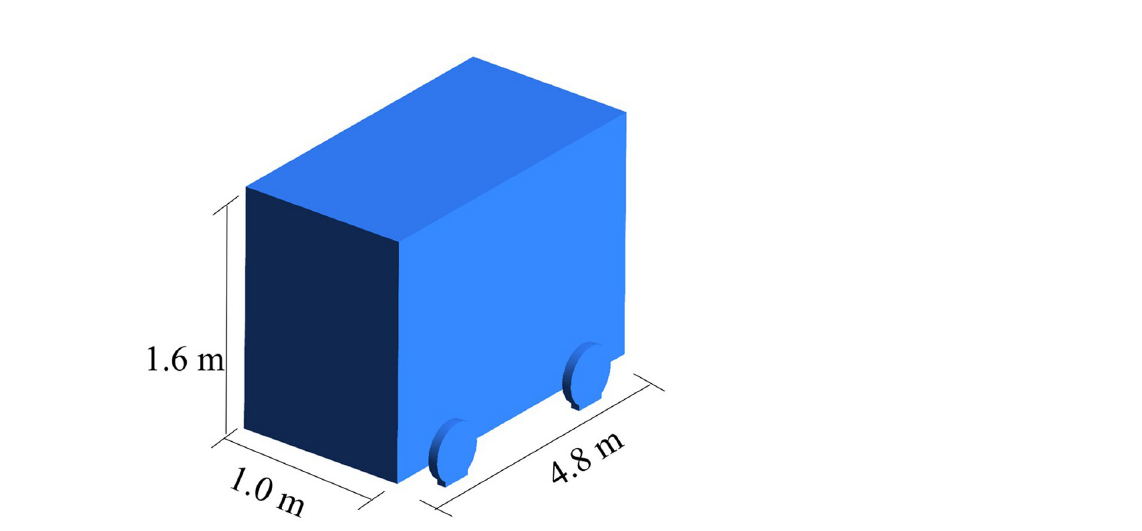
specific distributions of the two flow fields were similar.